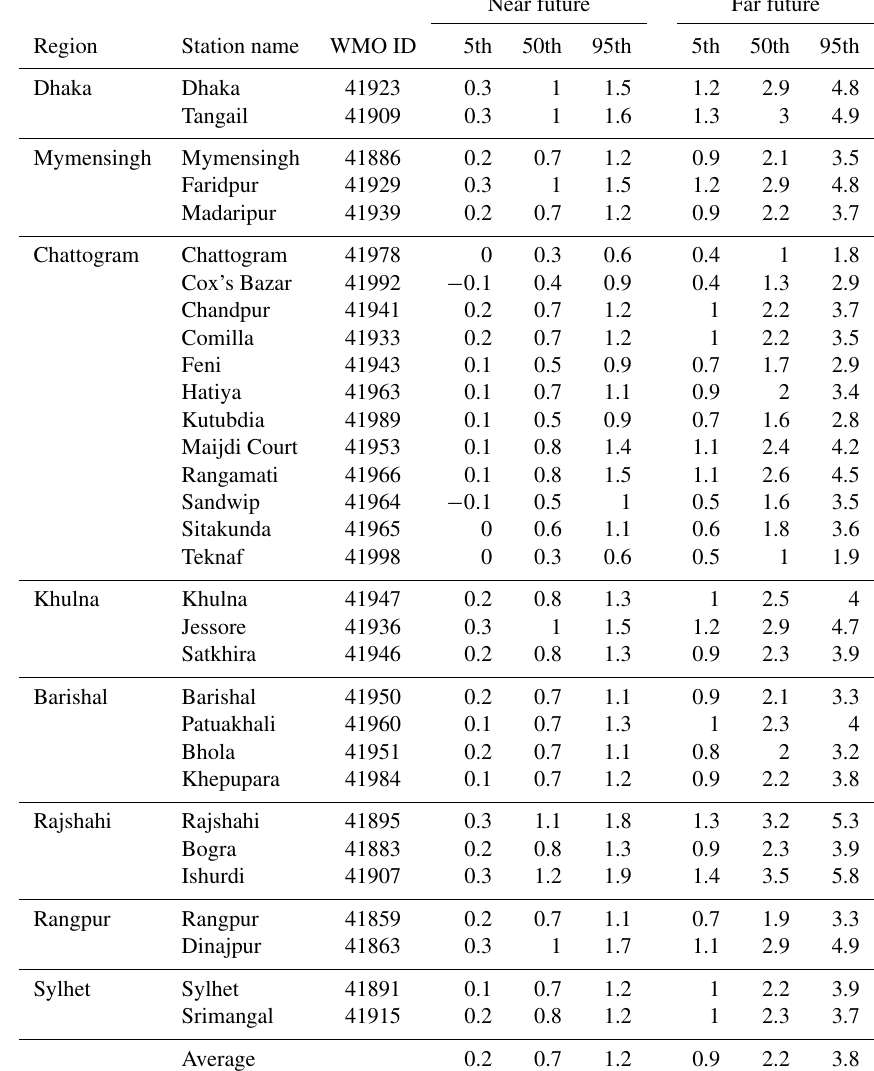
Table 4. The 5th, 50th and 95th percentile values of projected changes in maximum temperature (unit: ◦ C) in Bangladesh for the near future (2021–2050) and far future (2071–2100) relative to the 1981–2010 period for